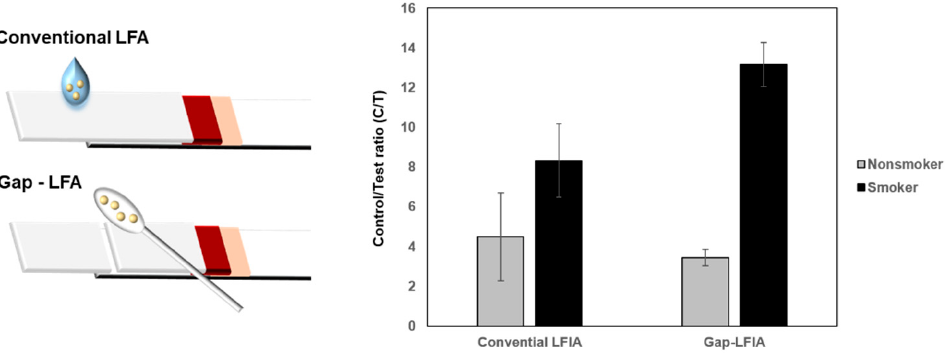
Figure 4. Comparison of C/T values of the conventional LFIA and gap-LFIA. All data shown are presented as the mean ± SD ( n = 3).